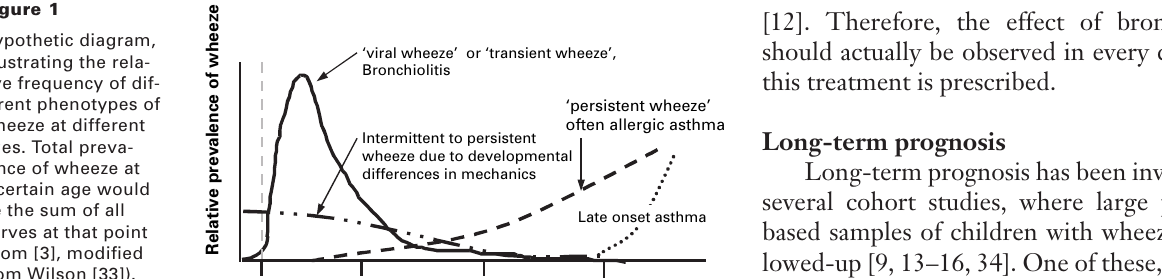
Hypothetic diagram, illustrating the rela- tive frequency of dif- ferent phenotypes of wheeze at different ages. Total preva- lence of wheeze at a certain age would be the sum of all curves at that point (from [3], modified from Wilson [33]).